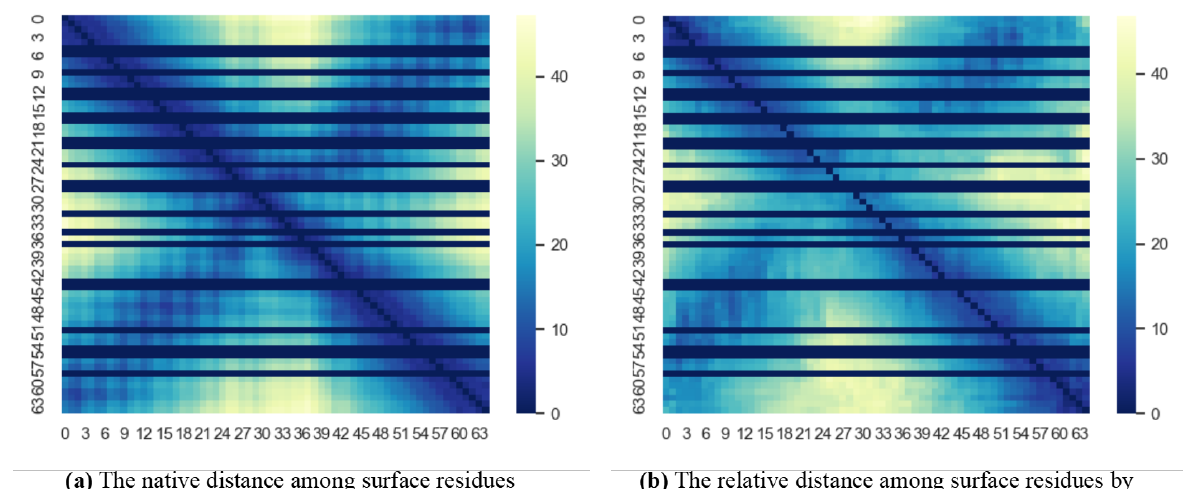
Figure 5. The prediction of TMP-SurResD on a TMP (PDB ID: 3DIN, chain E). Comparison of the native distance map ( a ) and the predicted distance map by TMP-SurResD ( b ). The horizontal and vertical coordinates indicate the number of residues, and the darker the color, the closer the residues are. Especially the dark horizontal bars in the figure indicate non-surface residues that are not